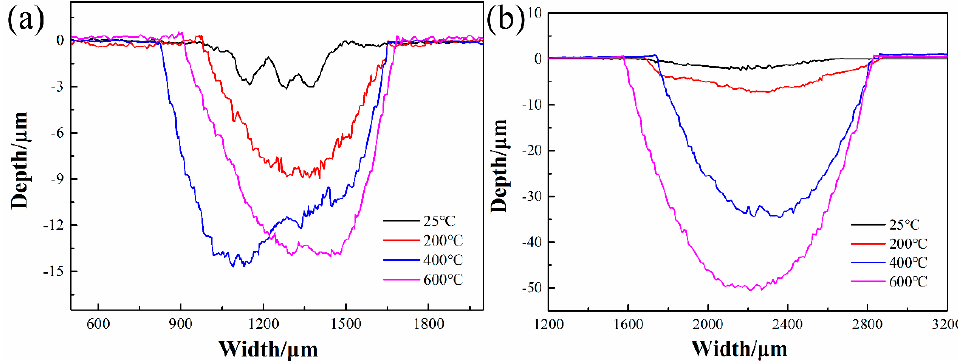
Figure 4. The wear profiles of worn tracks: ( a ) CoCrAlYTa-10%Al 2 O 3 coating; ( b ) H13 steel.